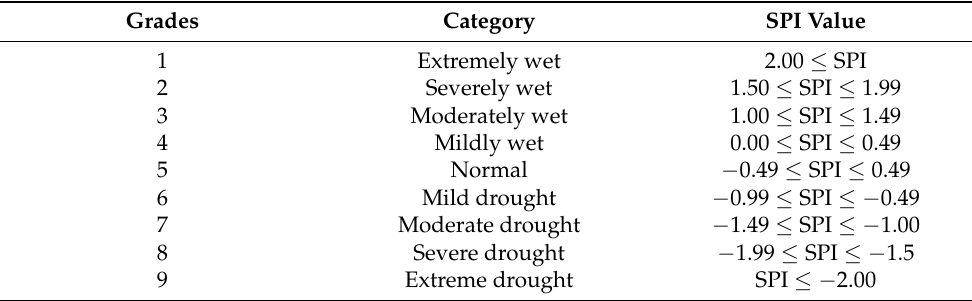
Table 1. Drought-flood grades of the standardized precipitation index (SPI).